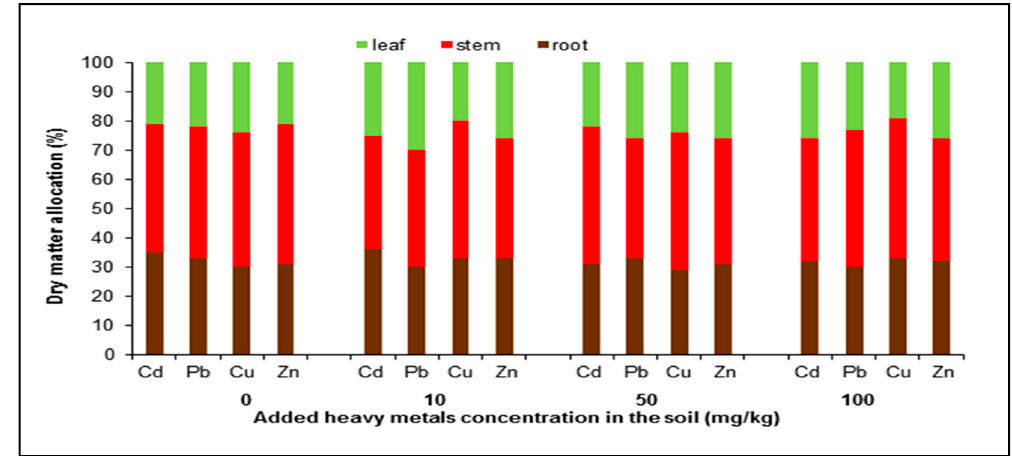
Figure 2. Dry matter allocation (%) of R. stricta plants under different heavy metal treatments across different plant organs. Soil treated with different heavy metals (Cd, Pb, Cu, and Zn) concentrations 10, 50 and 100 mg/kg soil in an open greenhouse.